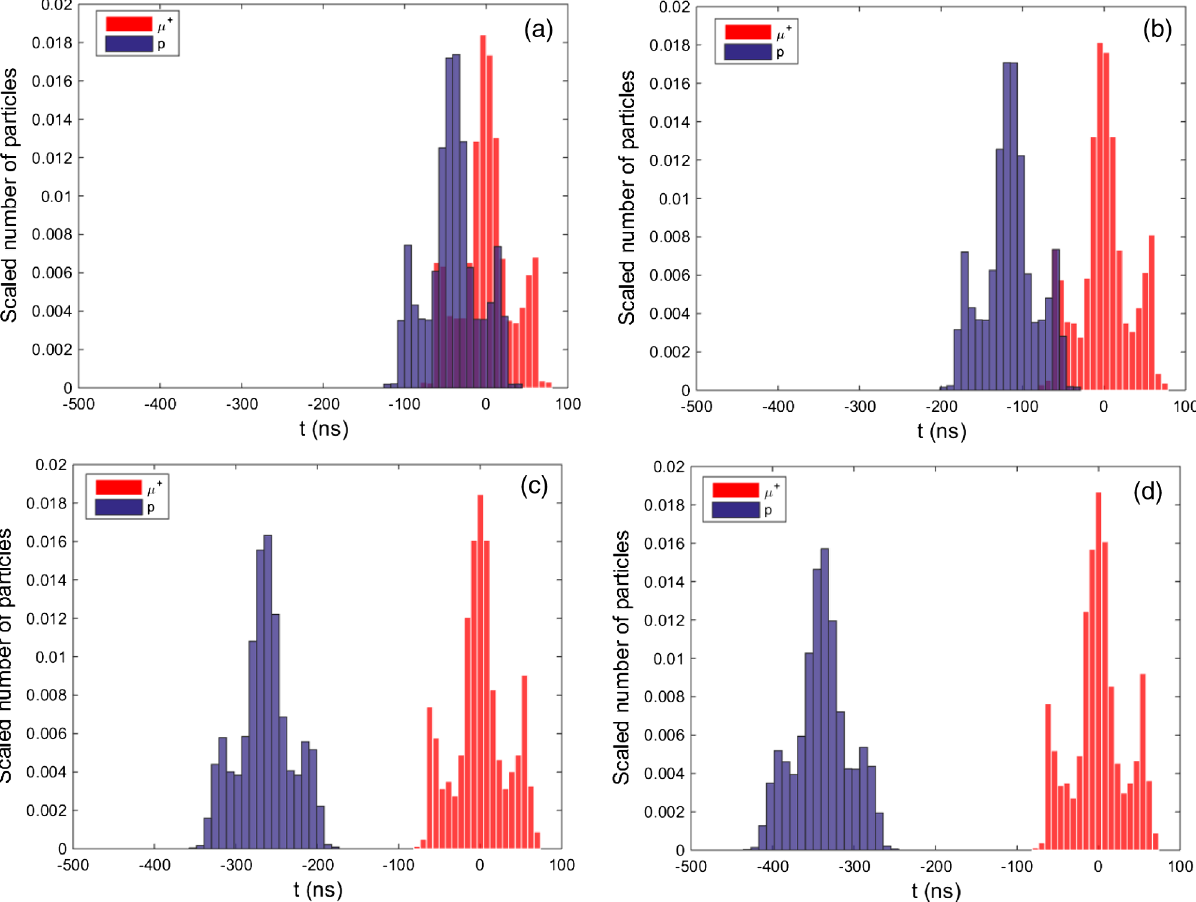
FIG. 10. The tracking of muon and proton longitudinal distributions along the DR: (a) entering, (b) after one turn in, (c) after three turns in, and (d) after four turns in the DR. The separation of muon and proton bunches increases by 75 ns after each turn. This plot indicates that four revolutions are required to safely remove the proton contamination, because of the ∼ 180 ns rise time for the proton removal kicker magnets. One should note that the histograms are normalized so that the area sum is equal to